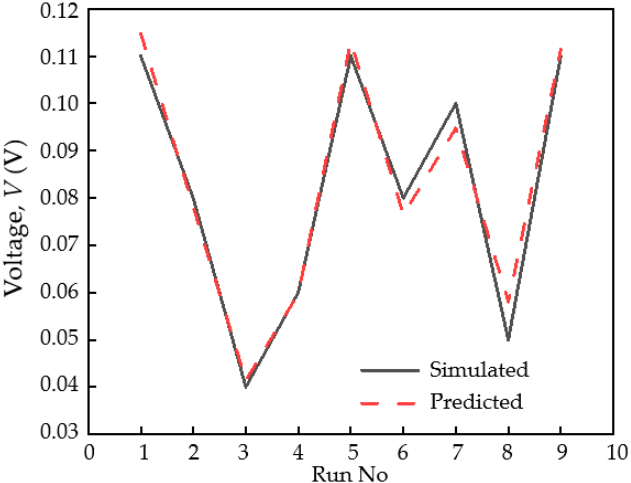
Figure 8. Comparison between predicted and simulated results for corresponding voltage, V peak .